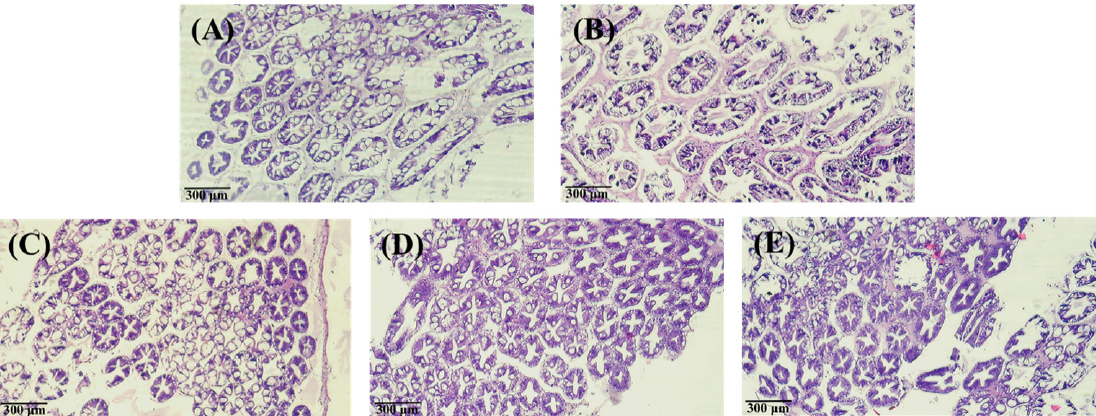
Figure 6. Inverted micrographs of H&E-stained hepatopancreas of white shrimp that containing ( A ) control at 0 h; ( B ) control at 240 h; ( C ) injection 50 µ g (g shrimp) − 1 PNWE at 240 h; ( D ) injection 100 µ g (g shrimp) − 1 PNWE at 240 h; ( E ) injection 200 µ g (g shrimp) − 1 PNWE at 240 h. (100 × ).